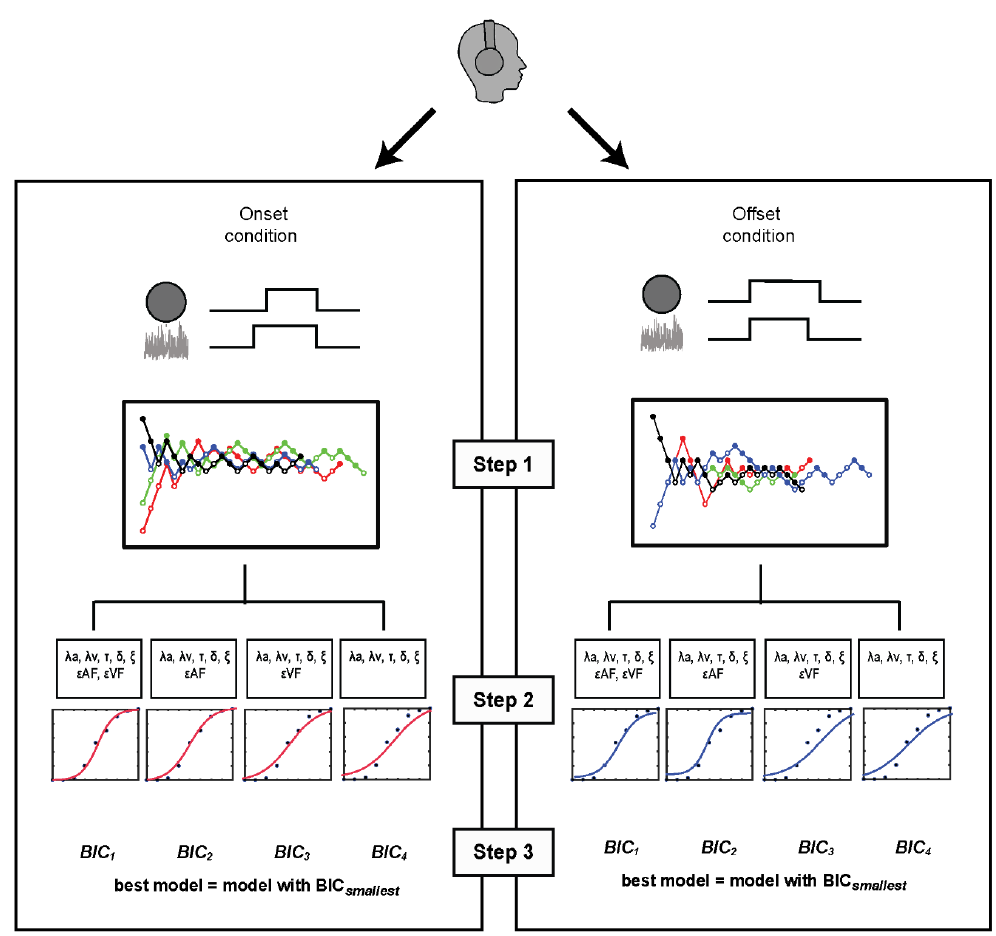
Figure 4. Model fitting approach. ( Step 1 ) For each participant, pool and bin event judgments from valid staircases for the onset condition and for the offset condition; ( Step 2 ) Deploy the “separate fit” method implemented by García-Pérez and Alcala-Quintana [24] to model the data separately for the onset and the offset conditions. In this step, 4 subsets of the full model were defined, a model with both response error parameters, models with one or the other of the two response error parameters, and a model with no response error parameters. All four subsets contained sensory, bias, and resolution parameters (see text for details); ( Step 3 ) For each subset model, parameter values giving the best fit (maximum likelihood) were determined, and the goodness of each fit was expressed using the Bayesian information criterion (BIC) index, with the “winner” for each condition (onset or offset) being the model with the smallest BIC value.